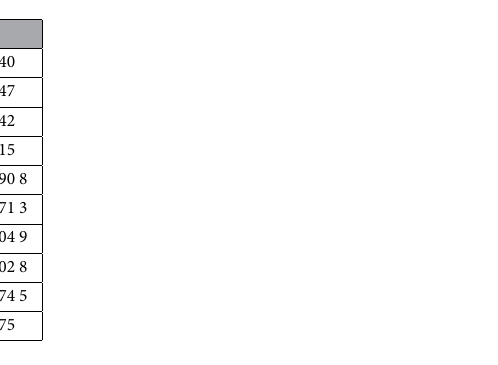
Table 2. Calculation results of different